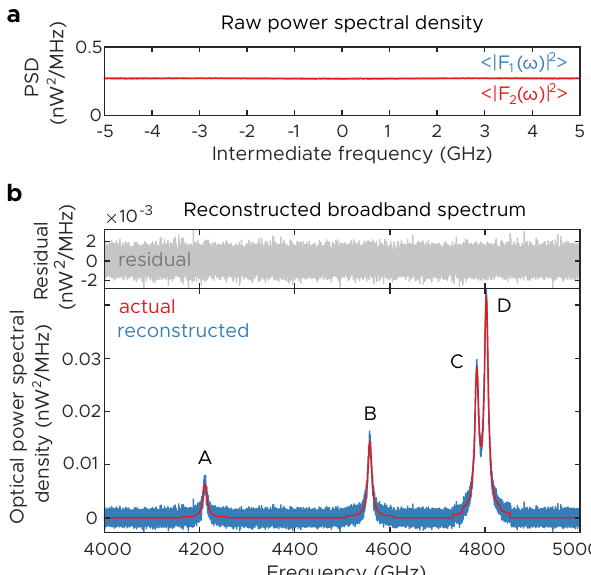
Fig. 4 Simulated broadband terahertz ptychoscopic experiment. a Raw power spectral densities of the recorded signals when the spectrum has components broader than the comb spacing. They are essentially fl at, having no discernible peaks. b Spectral reconstruction and true spectrum (10 MHz RBW, 9 ms measurement C and D are also correctly distinguished despite the fact that they overlap entirely with respect to both combs 1 and 2.